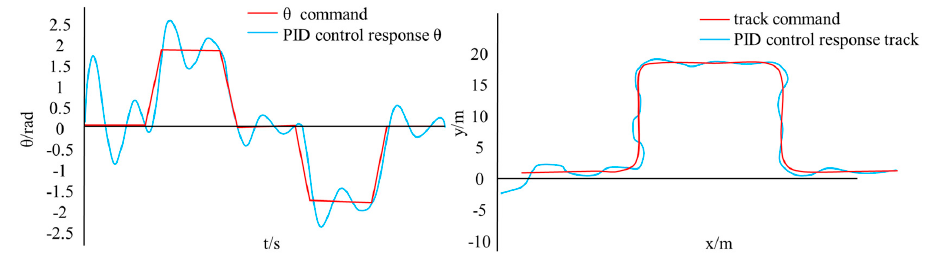
Figure 9. Schematic diagram of the angle θ response time and two-dimensional trajectory tracking of the PID algorithm when the broken line moves.